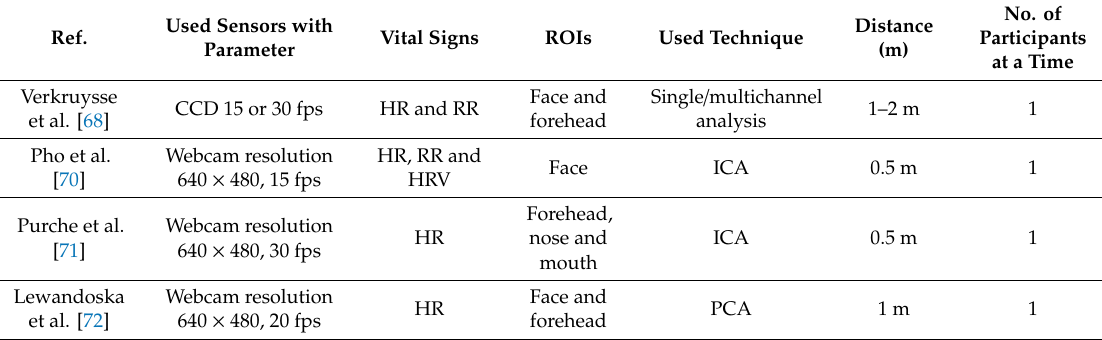
Table 1. imaging photoplethysmography (iPPG) based methods under well controlled conditions.